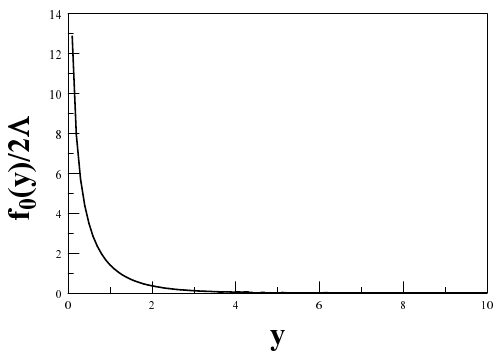
Figure 1. The distribution function f 0 ( y ) = n ( y ; ∞ )